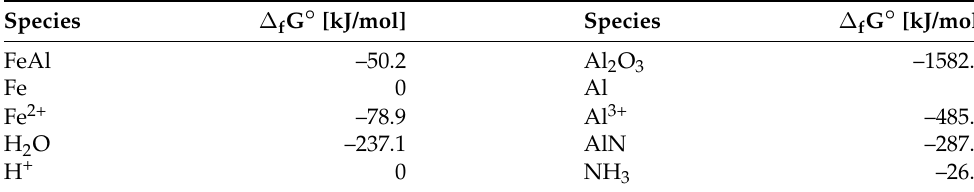
Table 7. Selected standard Gibbs free energies ( Δ f G ◦ ) of formation